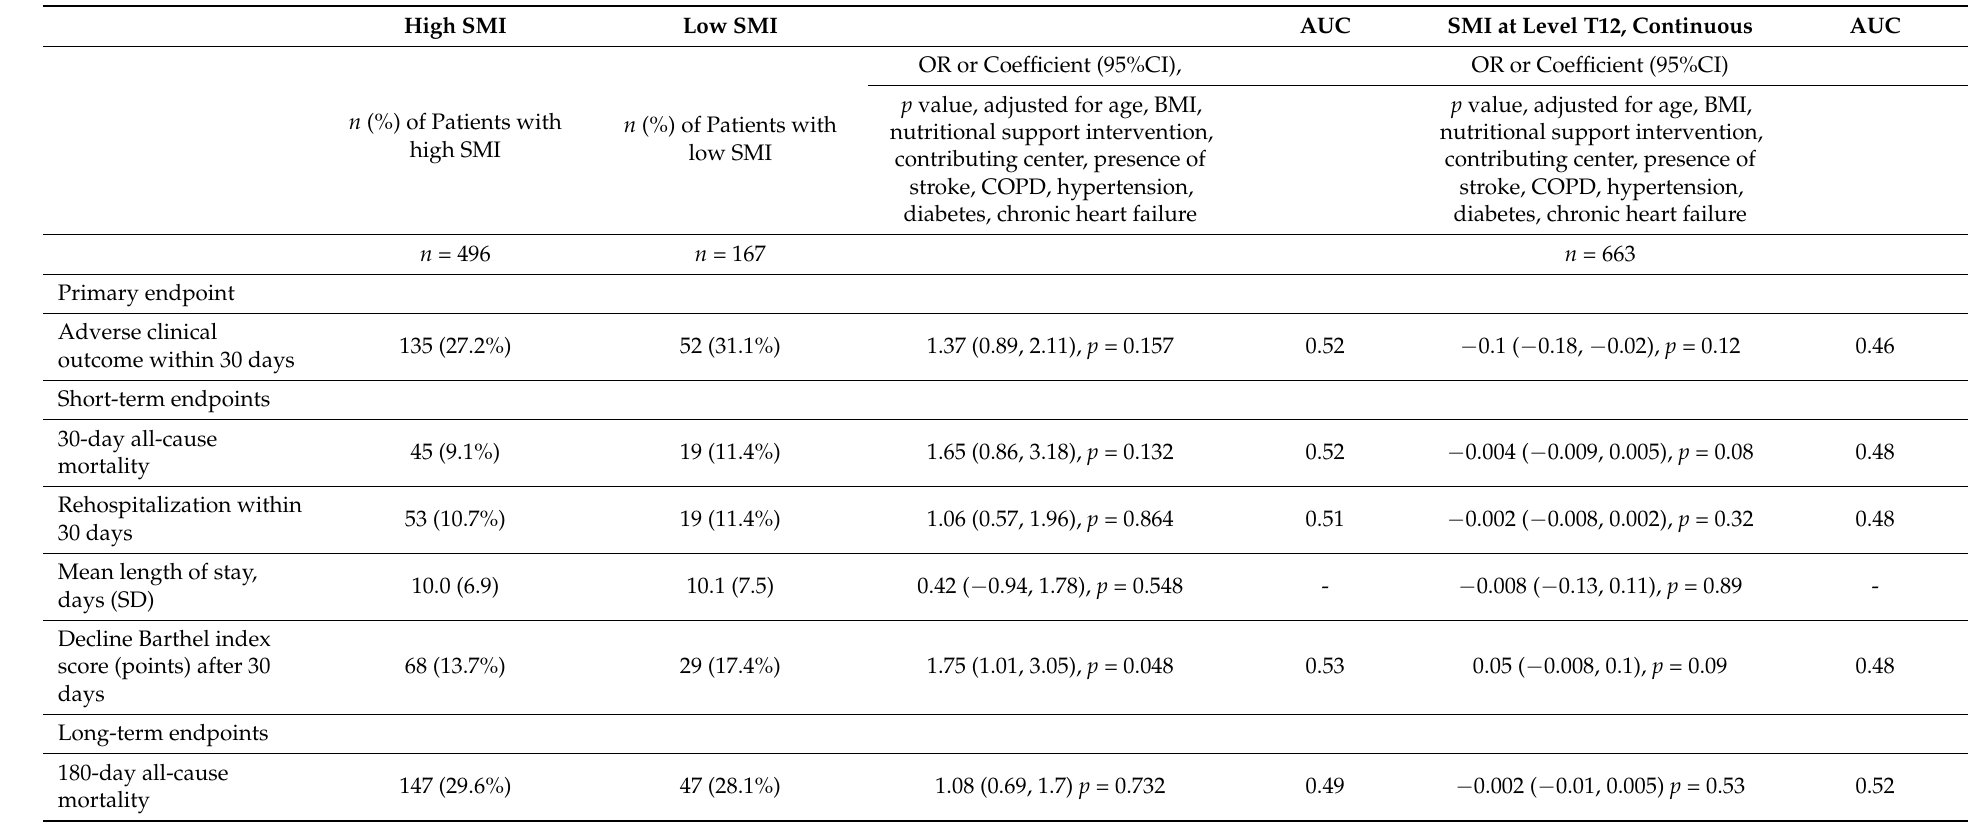
Table 3. Association of low SMI at level Th12 with clinical outcomes. High SMI Low SMI AUC SMI at Level T12, Continuous AUC